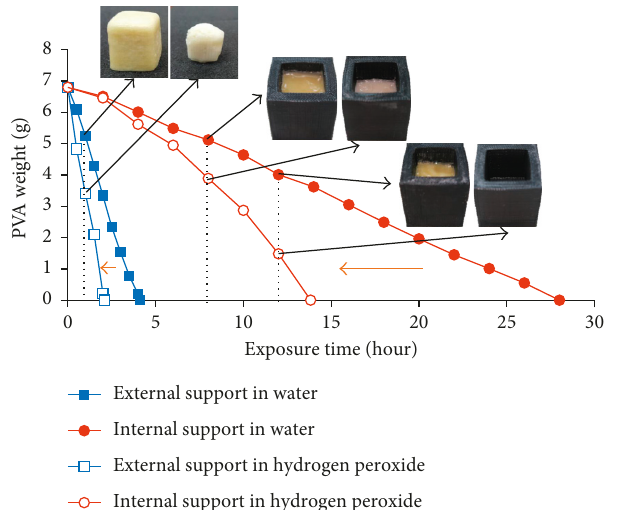
Figure 5: Dissolution rates of external- and internal-type PVA support samples in water and hydrogen peroxide.